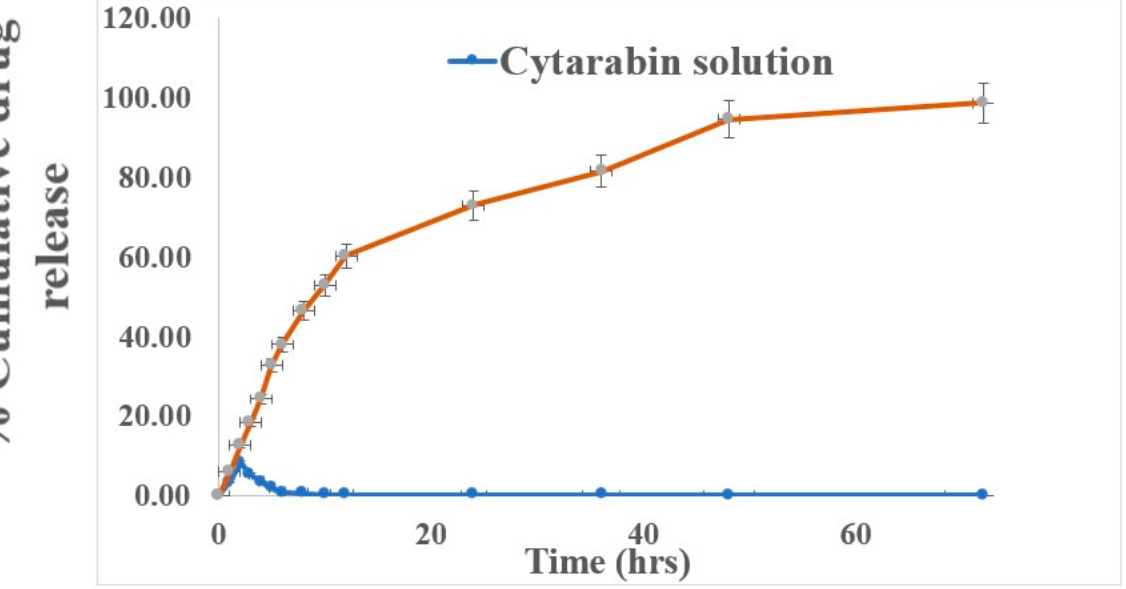
Figure 7. In vitro dissolution profile data for cytarabine solution and developed CY-TINPs formula- tion in PBS (PH